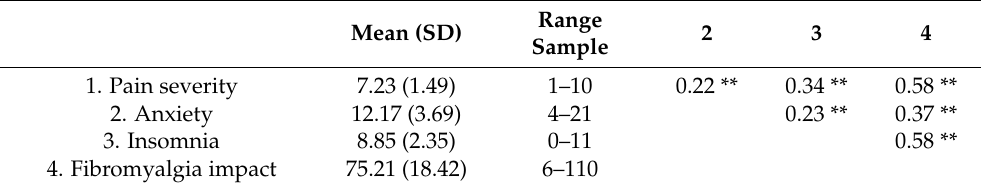
Table 2. Means, standard deviations, and Pearson correlations between study variables.